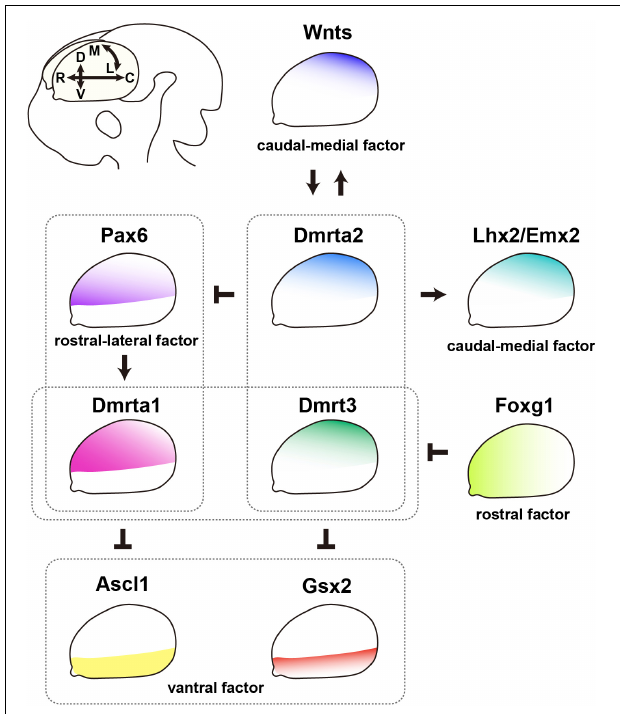
FIGURE 2 | DmrtA subfamily members contribute to the patterning of the telencephalon. Regulatory networks of telencephalic patterning molecules related to the contribution of DmrtA subfamily members (DmrtAs). DmrtAs are involved in subdivision along the dorsoventral axis of the telencephalon. Dmrta1 is a direct target of the transcription factor Pax6, which exhibits a rostral-high/lateral-high gradient expression. Dmrta1 represses Ascl1 expression in the ventral telencephalon, while Dmrt3 and Dmrta2 directly repress the expression of Gsx2 . Therefore, DmrtAs are essential for determining the dorsoventral identity of progenitor cells by repressing ventralization. DmrtAs play roles in mediolateral patterning of the dorsal telencephalon. The caudal-medial signaling center secretes Wnts that are required for the formation of the medial telencephalic structure. Wnts and DmrtAs mutually regulate each other. Dmrt3 and Dmrta2 mainly determine the proper patterning of the caudal-medial telencephalon. Dmrta1 supports medial telencephalic development. The rostral factor Foxg1 represses Dmrt3 and Dmrta1 expression, and this molecular pathway may be needed to acquire the caudal-medial fate specification. Furthermore, Dmrta2 modulates the expression of transcription factors such as Pax6 , Emx2 , and Lhx2 , leading to the proper patterning of the neocortex. C, caudal region; D, dorsal region; L, lateral region; M, medial region; R, rostral region; V, ventral